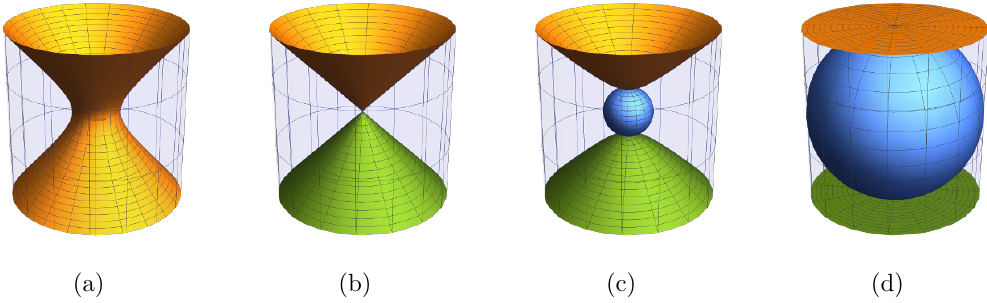
Figure 11. 10+2d lift of D1-branes probing the circular array of NS5-branes. (a) The dS 2 brane is the lift of a D1-brane passing outside the ring; (b) Degeneration limit where the dS 2 brane splits into a pair of H 2 branes; (c) H 2 brane segments are the lift of D1-branes that extend to in(cid:12)nity and end on NS5-branes (the latter being the 10+2d locations where the gauge group action degenerates), while an S 2 brane describes the D1 segment extending between NS5-branes; (d) Maximum size S 2 segment extends between minimum H 2